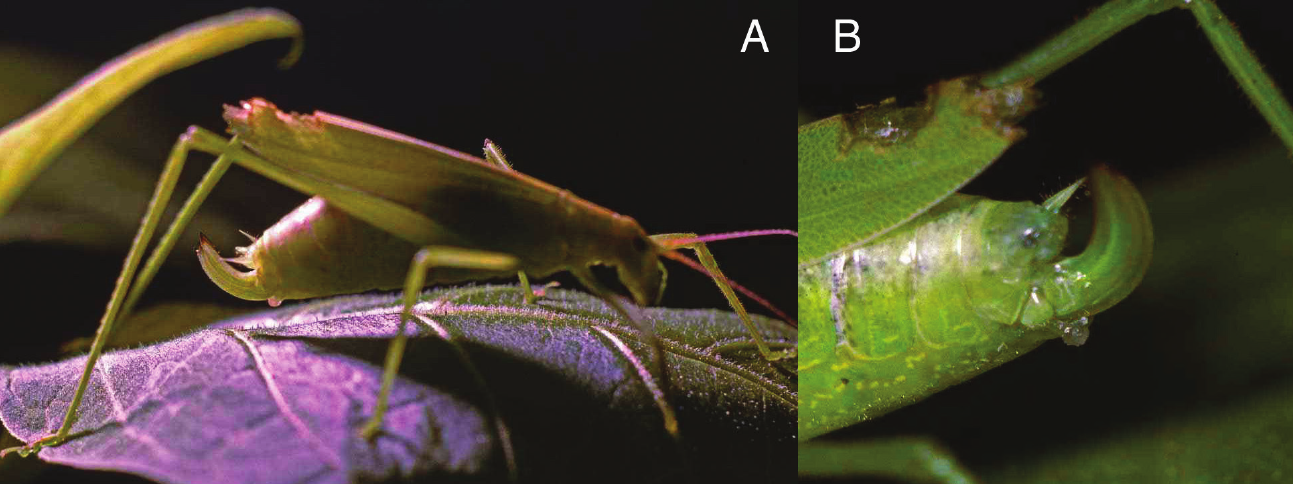
Besides the acoustical signals soundless vibratory body move- ments were observed in both